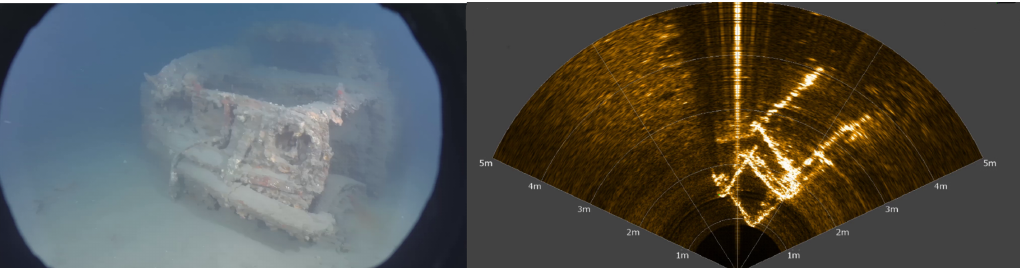
Figure 2. Optical image of a car acquired by a UHD (4K) camera (on the left) and the corresponding acoustic image obtained by a multibeam imaging sonar (on the right). One can observe the bright lines corresponding to the edges of the